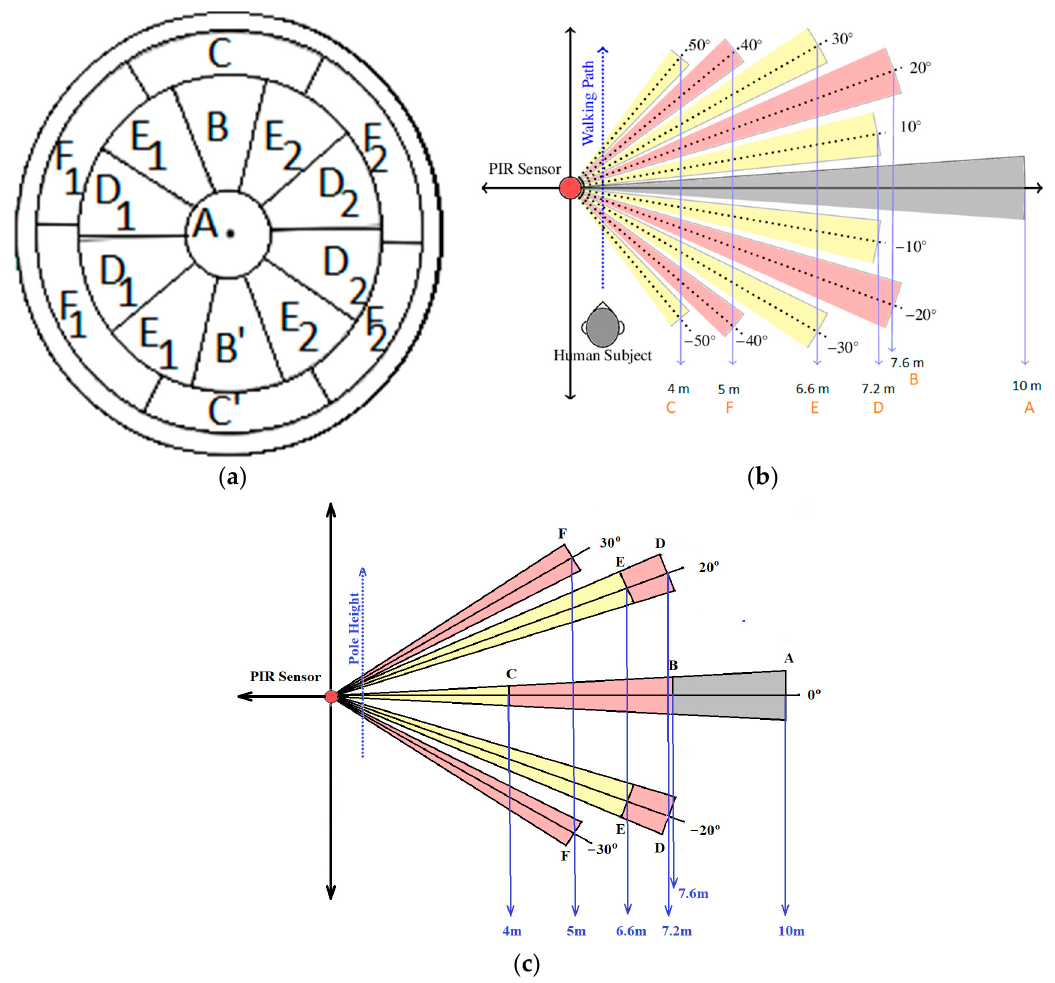
Figure 1. ( a ) Segmentation of Fresnel lens [21], ( b ) top View of FoV of Fresnel lens [18], and ( c ) side view of FoV of Fresnel lens. Table 2. Measured coverage ranges of different regions of Fresnel lens at full and reduced sensitivity mode.